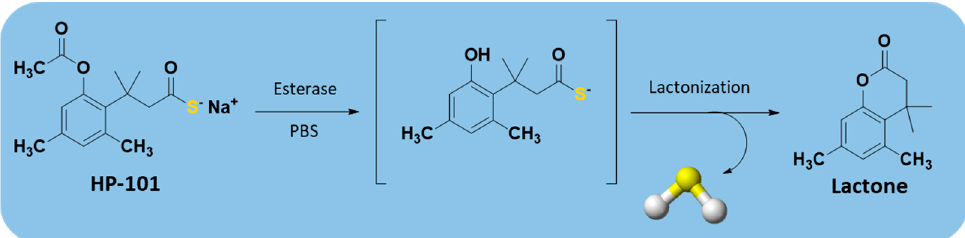
Figure 13. Mechanism of esterase-triggered H 2 S release.